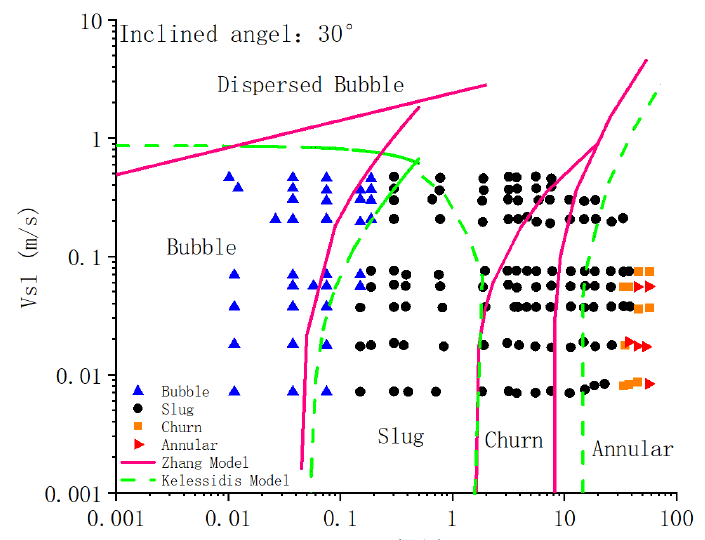
Figure 9. Comparison between flow pattern diagrams of different models and experiments with 30° inclination angle.